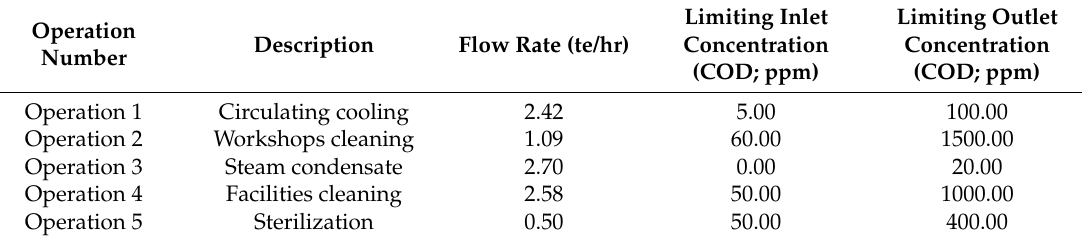
Table 2. Water using operations summary for water pinch